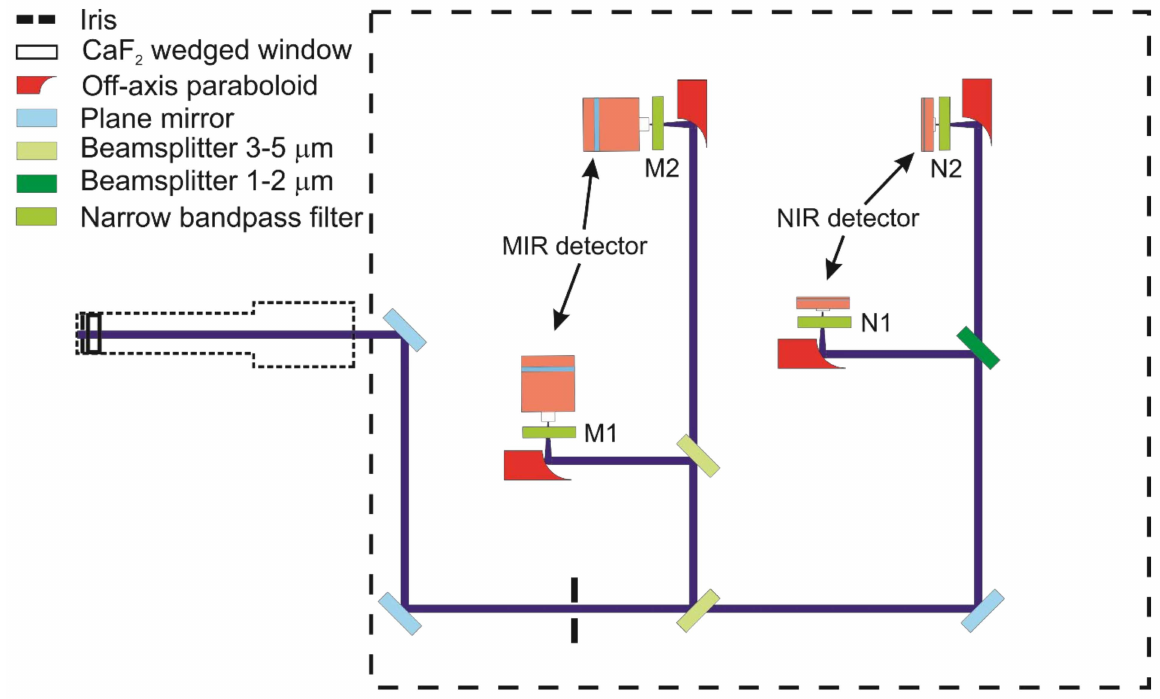
Figure 6. Schematics of the receiving